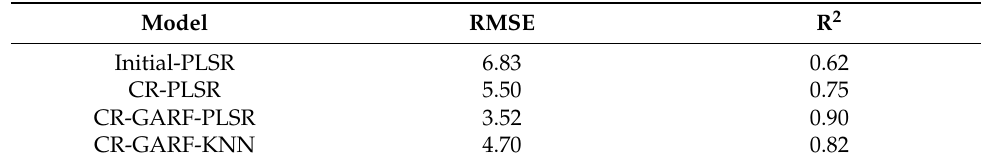
Table 4. Estimation accuracies of soil petroleum hydrocarbon content.